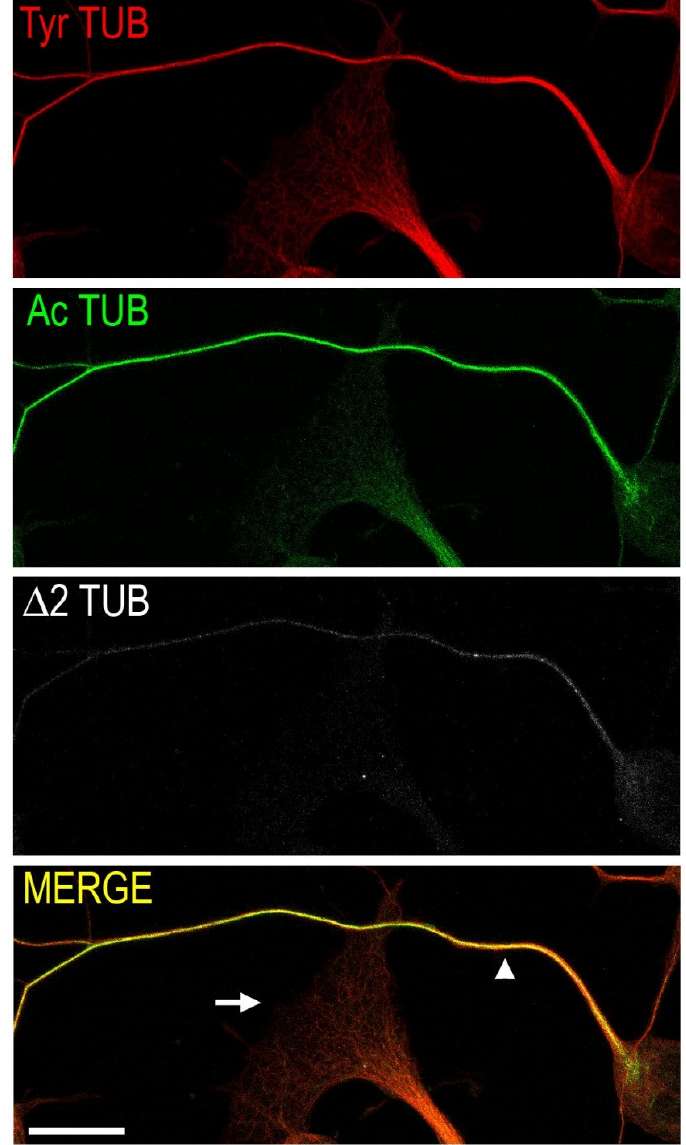
Figure 1. Confocal micrograph of cultured neurons, showing a conventional distribution of different tubulin post-translational modifications along the axon (arrowhead) and inside an enlarged terminal (arrow). Tyrosinated tubulin (Tyr TUB, red) is present in the axon and constitutes the microtubule network at the terminal; acetylated tubulin (Ac TUB, green) is enriched along the axon and barely present at the tip; Δ 2 tubulin ( Δ 2 TUB, white) is detectable only in the axon shaft showing a proximal-to-distal distribution. Scale bar = 15 µm.